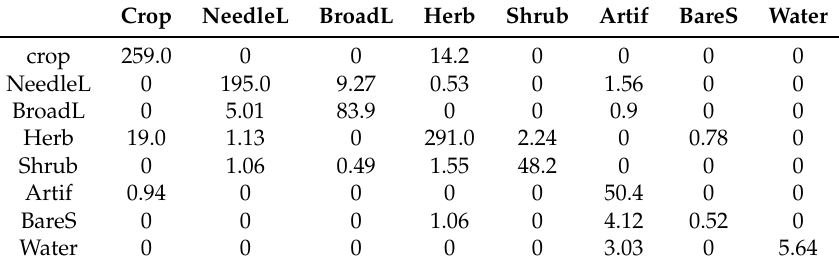
Table A2. Confusion matrix with case study errors and large overall